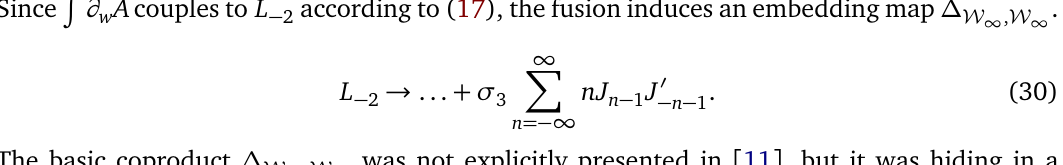
Figure 3: The top figure shows the quantum correction on the Wilson line OPEs from the interaction with the 5d Chern-Simons theory. The formula ( ∼ σ for the fused Wilson line can be obtained by computing the Feynman diagram. As A is t the representation associated with ∂ 2 , the OPE directly gives the coproduct 2,0 z → ... σ t t formula ∆ : t A , A 2,0 3 0, m 0, n